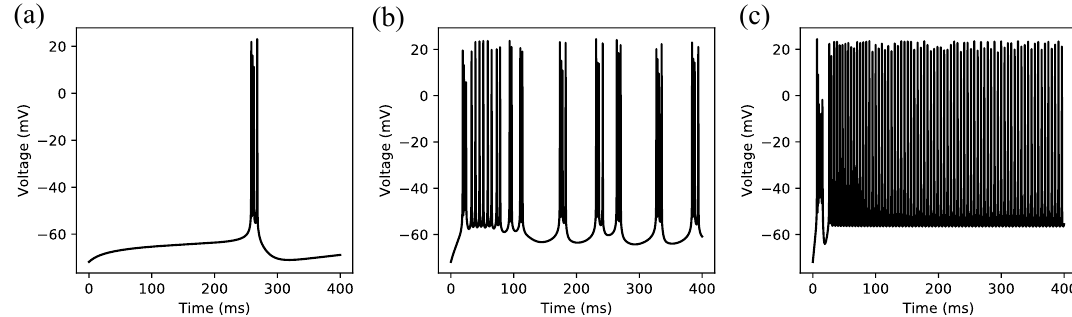
Figure 5. Diversity in the spiking patterns of hippocampal CA1 pyramidal neurons to applied currents. ( a ) Regular bursting in response to the external current of 0.23 nA. ( b ) Irregular bursting in response to the external current of 1.0 nA. ( c ) Plateau potentials followed by regular spiking in response to the external current of 3.0